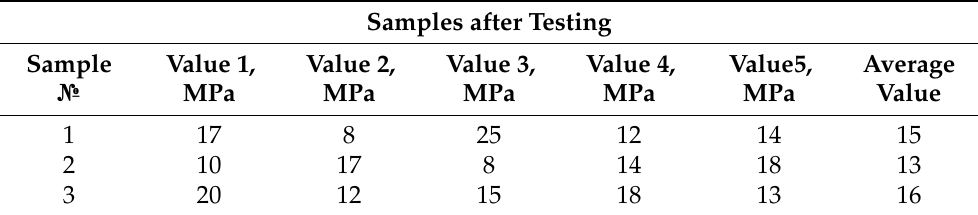
Table 3. Results of pull-off test after autoclave decompression